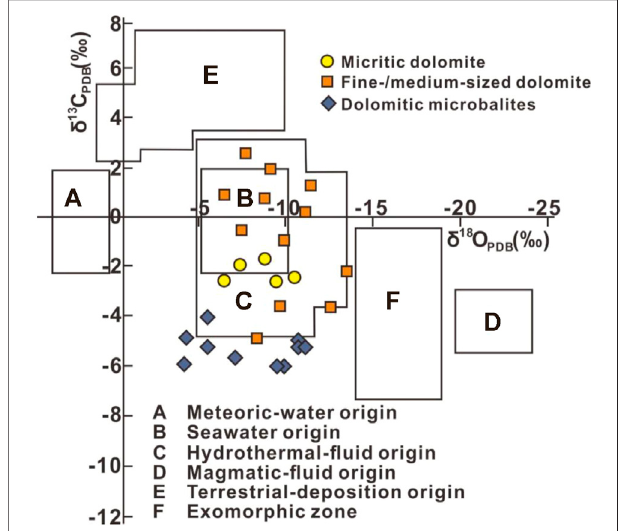
FIGURE 5 | Crossplot showing carbon and oxygen isotope features of different types of dolomites. The isotopic ranges are referred from Li et al.